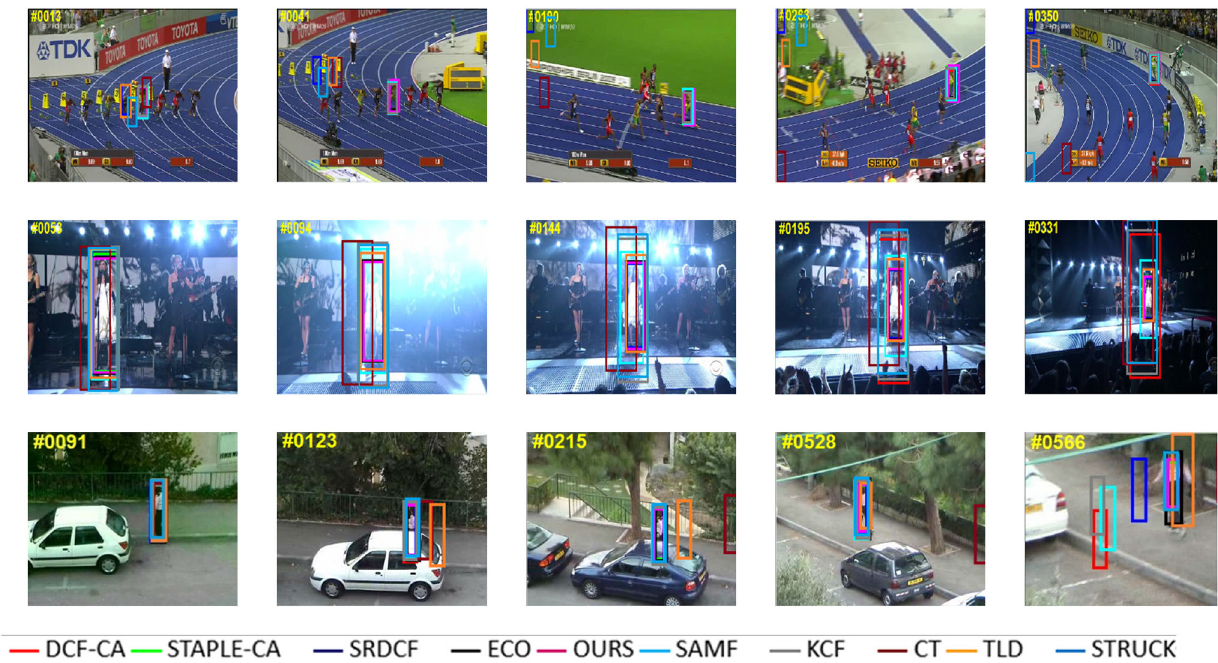
Fig. 11 Comparison of tracking effects of multiple trackers under deformation and lighting changes